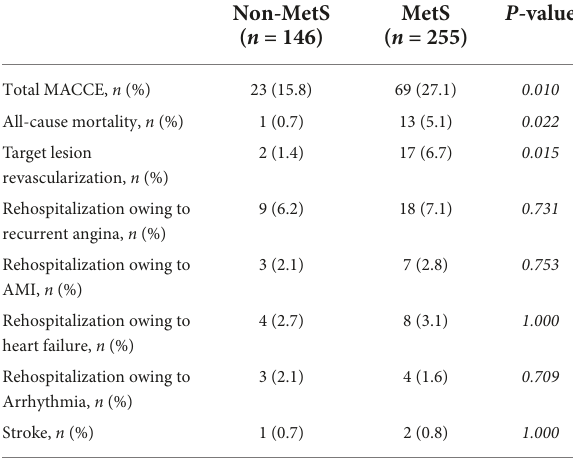
TABLE 1 Baseline clinical characteristics of all participants. TABLE 2 Category of MACCE occurred during the follow-up